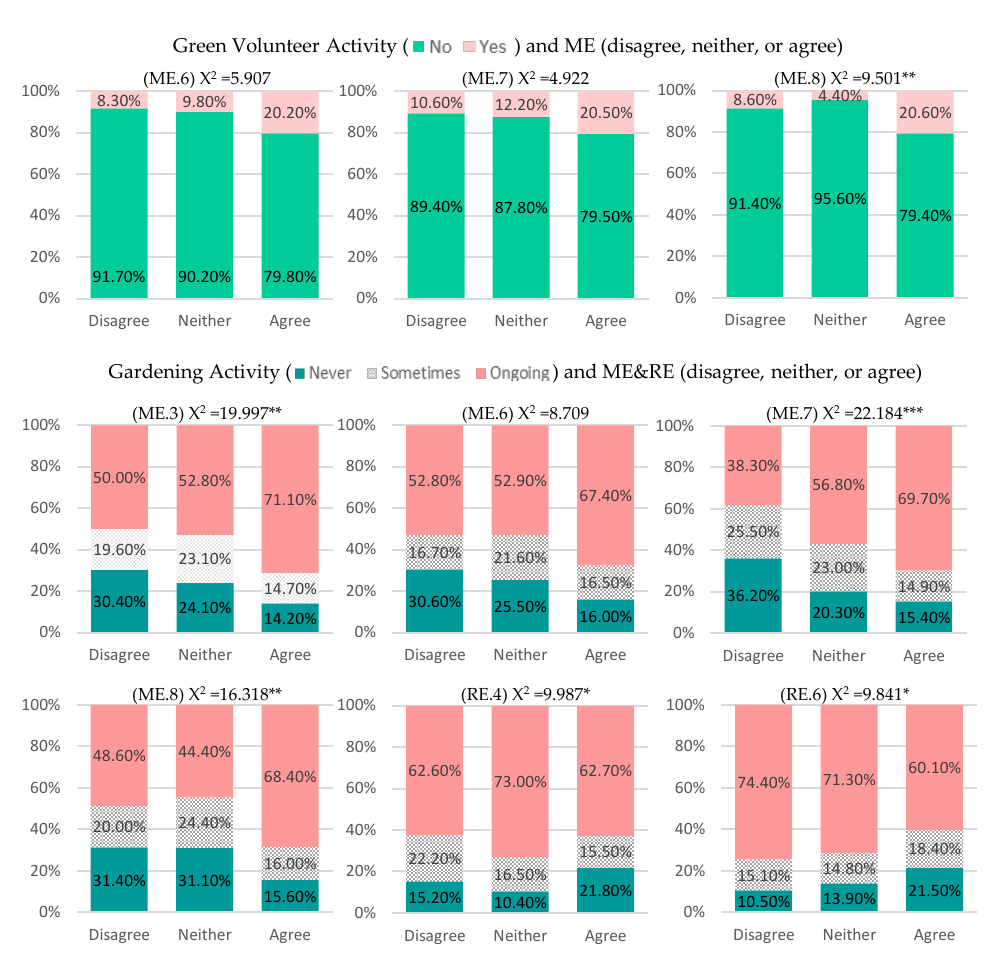
Figure 7. X 2 -test between greenspace management experience and ME&RE; * p < 0.05, ** p <